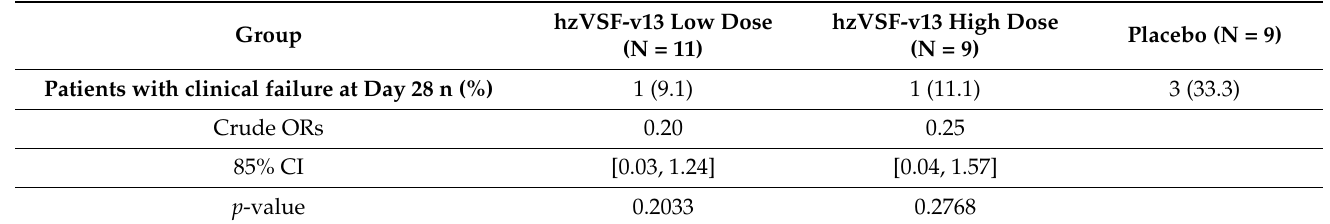
Table 3. Clinical failure: stratified analysis in severe patients at Day 28. Full analysis set (FAS).